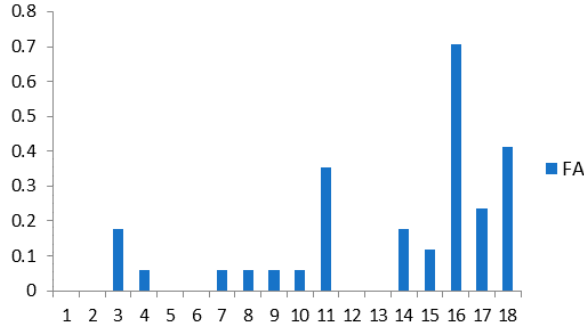
Figure 6. FA rate of each individual in T 1 .